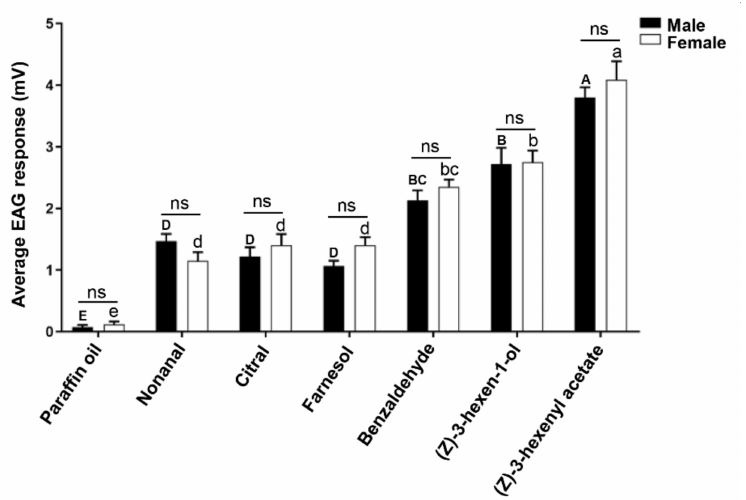
Figure 8. EAG responses of male and female Peridroma saucia to host plant volatiles. Two- to three- day-old males and females of P . saucia were used for EAG tests with six host plant volatiles that had substantial binding affinities to PsauGOBP1 in the competitive-binding assays. The dose of each tested compound was 100 µ g, and unpaired Student’s t -test indicated that the EAG responses did not significantly differ ( p > 0.05) between male and female antennae (as indicated by “ns”). Values above bars are means + SE (n = 20). According to one-way ANOVA followed by the Tukey multiple comparison test, means with different uppercase letters indicate significantly different ( p < 0.05) responses of male antennae, and means with different lowercase letters indicate significantly different responses ( p < 0.05) of female